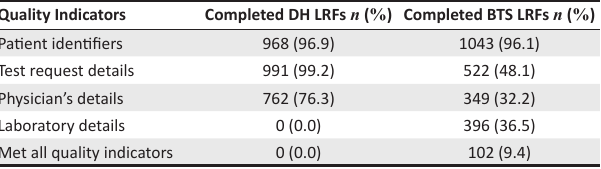
TABLE 3: Completeness of laboratory request forms submitted to Department of Haematology ( n = 999) and Blood Transfusion Services ( n = 1085) of Aminu Kano Teaching Hospital, Kano, Nigeria, from October 2014 to December 2014: Analysis based on major quality indicators according to International Federation of Clinical Chemistry - Working Group.